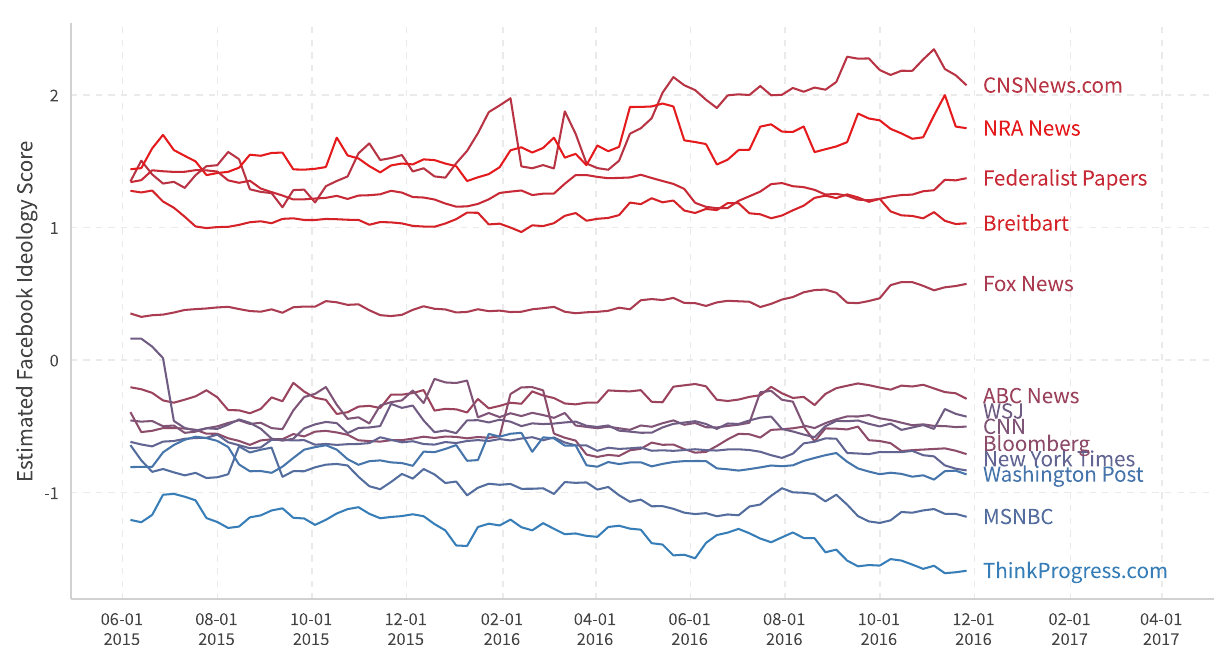
Fig 10. Ideological time series for selected news outlets. We use the data inside a moving window of one month (last 28 days) that updates every week to capture the dynamics of pages.